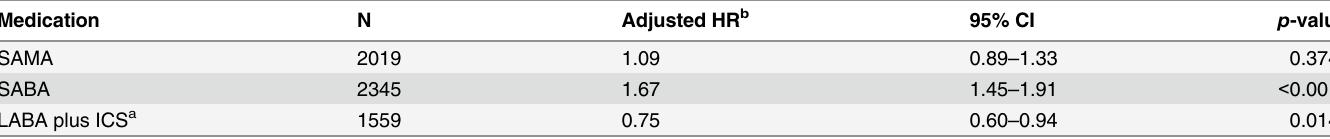
Table 4. Adjusted Hazard Ratios for Stroke between COPD Patients with or without Using the Inhaled Pharmacotherapy by Propensity Score Cali- bration Method.